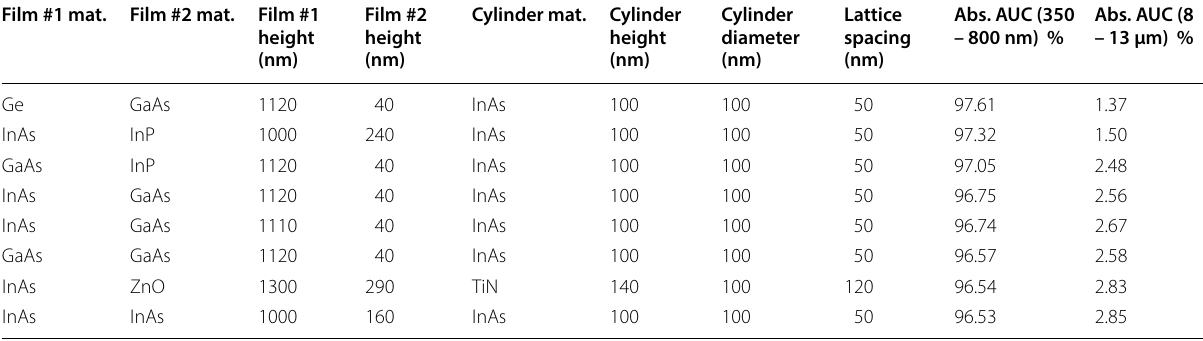
Table 3 Some of highest efficiency structures by the